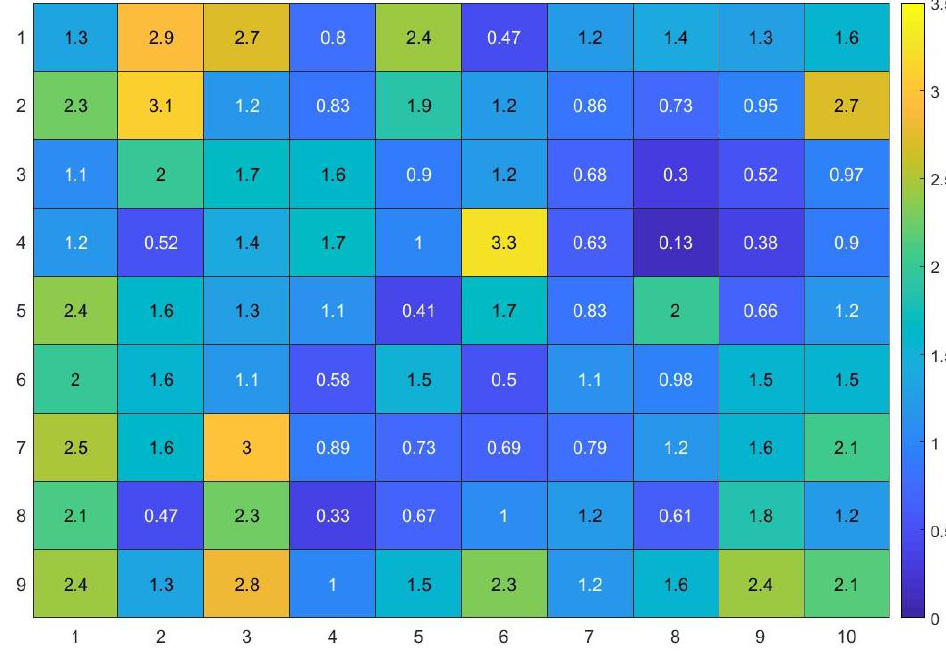
Figure 12. Estimation error (m) calculated for each test point.